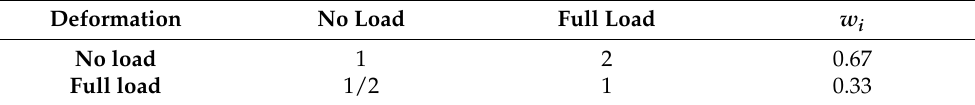
Table 23. Important judgment matrix of deformation under different operating